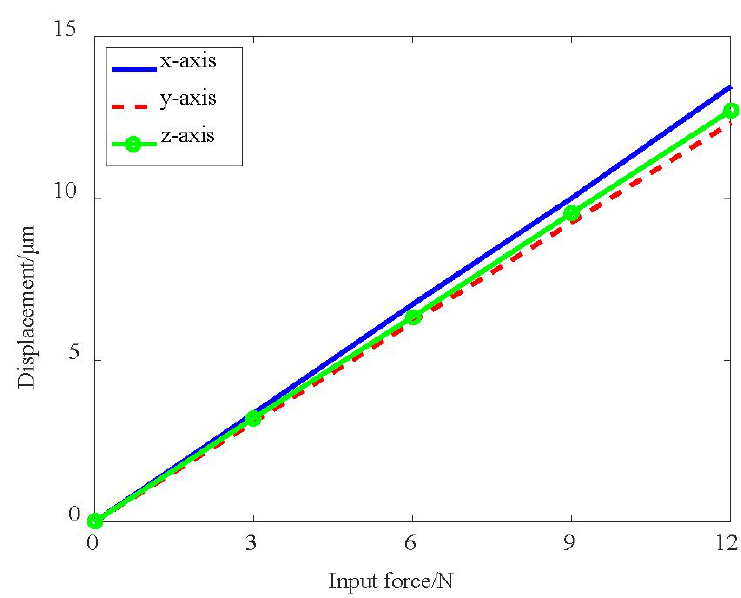
Figure 7. Flowchart of the FEA simulation.